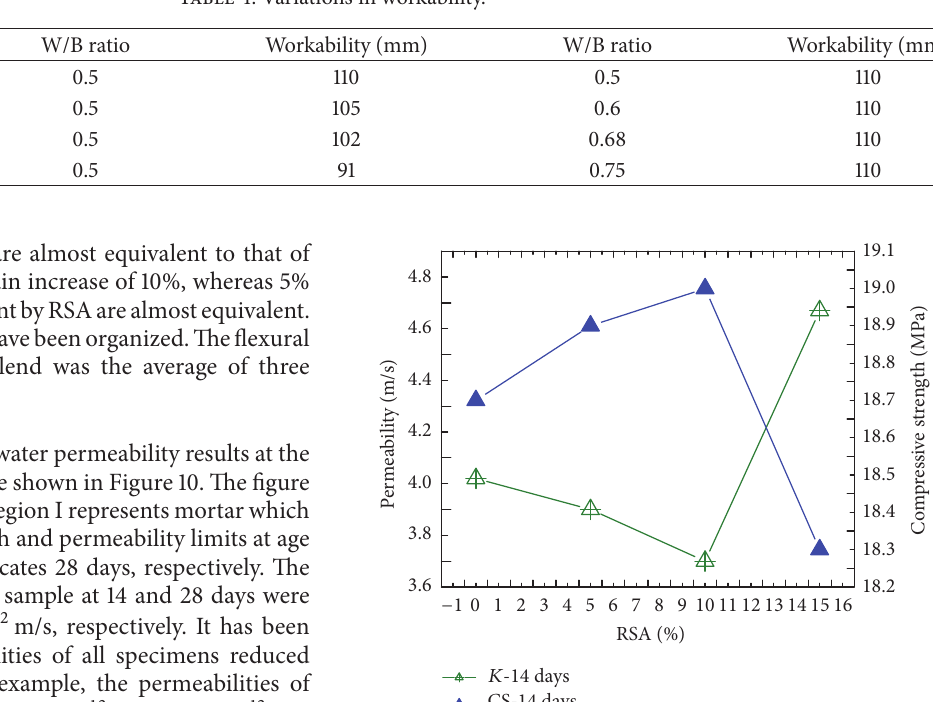
Figure 10: Permeability at 14 and 28 days. Table 4: Variations in workability.